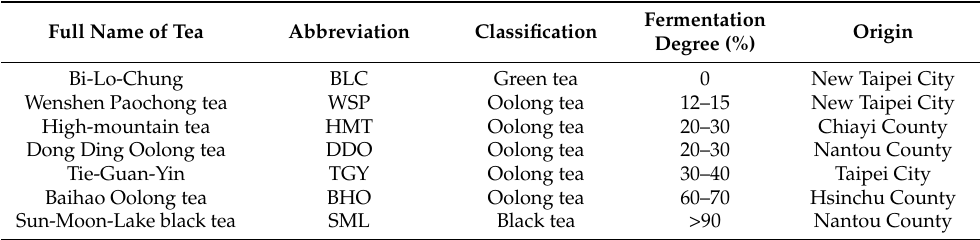
Table 1. The information for seven Taiwanese specialty teas in this study